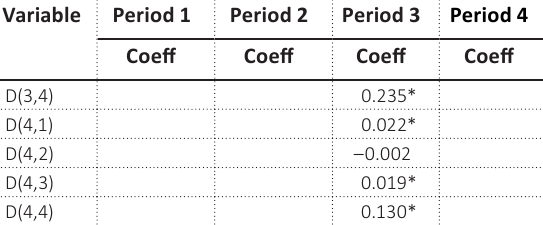
Table 3. Results of the BEKK–GARCH